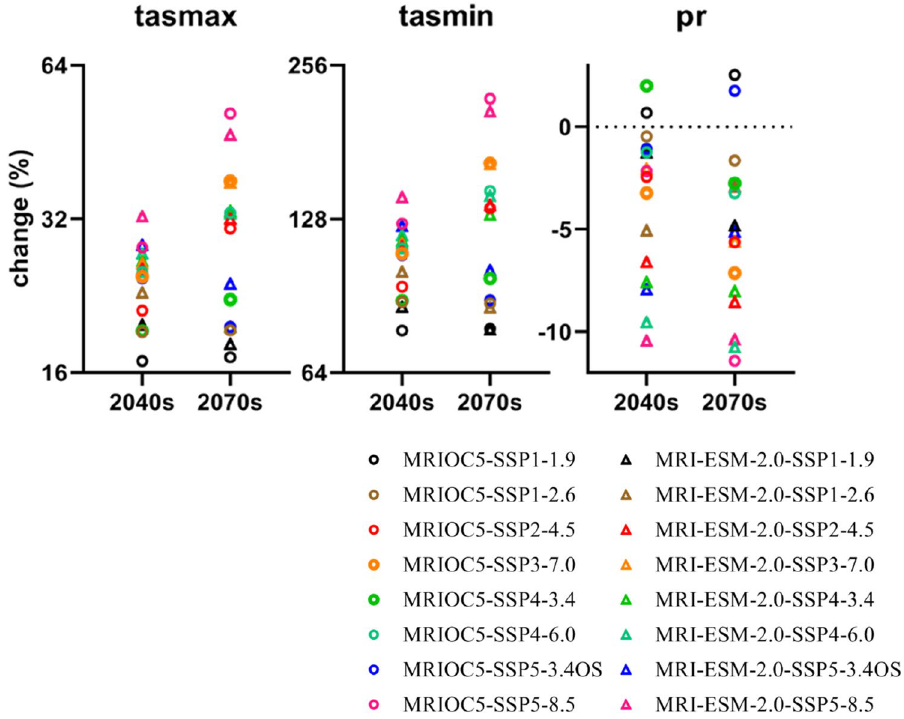
Figure 9. Percent change of average maximum temperature (tasmax), minimum temperature (tasmin), and precipitation in the 2040s and 2070s, with respect to the baseline